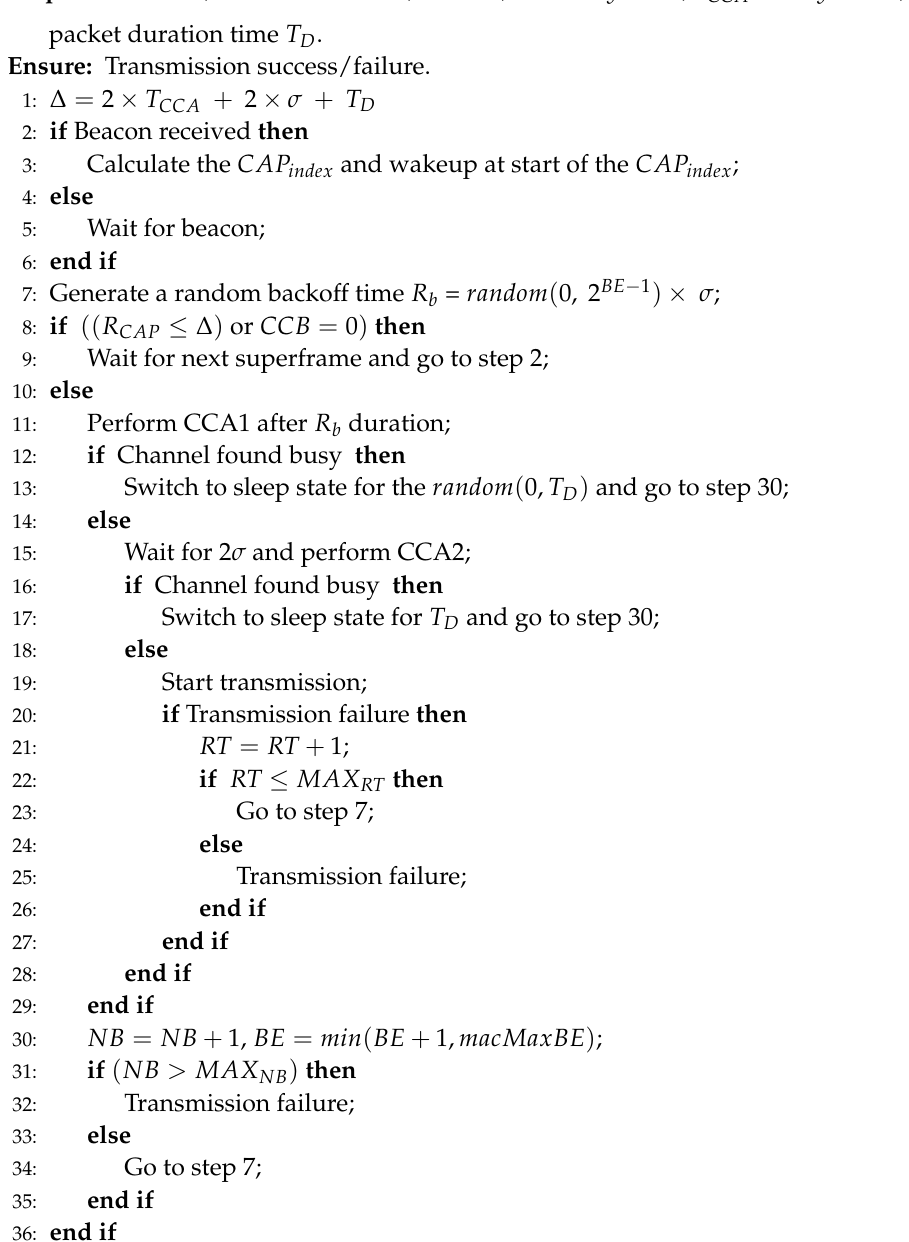
Algorithm 3 New channel access